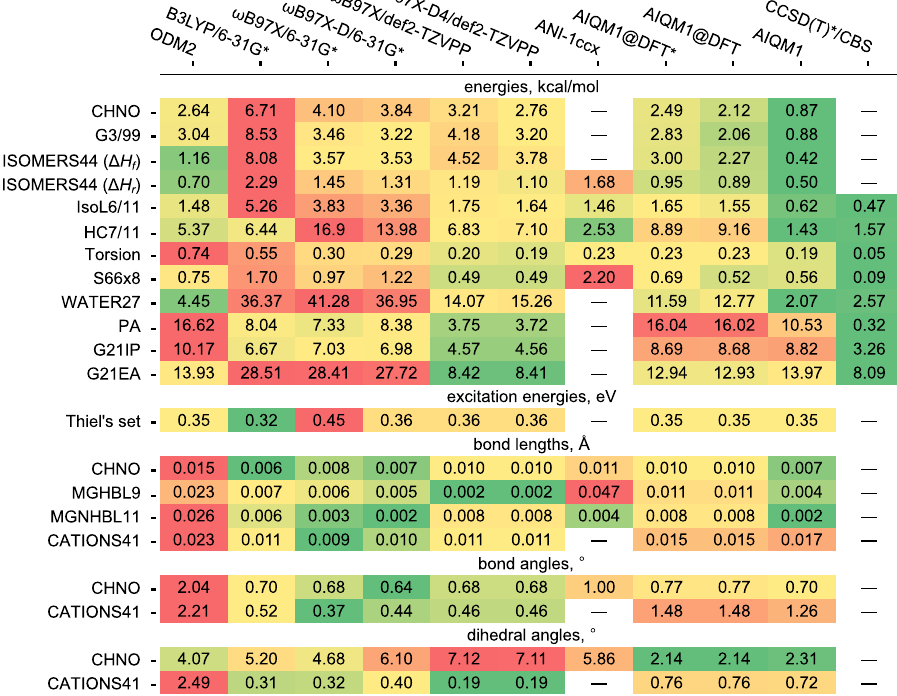
Fig. 4 Performance of tested methods for diverse benchmarks. Mean absolute deviations (MADs) are provided for all methods and benchmark sets used in this study. MADs are color coded for easier visual analysis — red values have the highest MAD, green values — the lowest. “ ― ” is used where (all) calculations were not possible. Data set abbreviation are their established names, i.e., CHNO — compounds with H, C, N, and O elements, G Gaussian, IsoL isomerization of larger molecules, HC hydrocarbons, IP ionization potentials, EA electron af fi nities, MGHBL main-group hydrogenic X – H bond lengths, MGNHBL11 main-group non-hydrogenic X – Y bond lengths; the numbers in data set names usually indicate either the original number of data points in the data set or a year it was